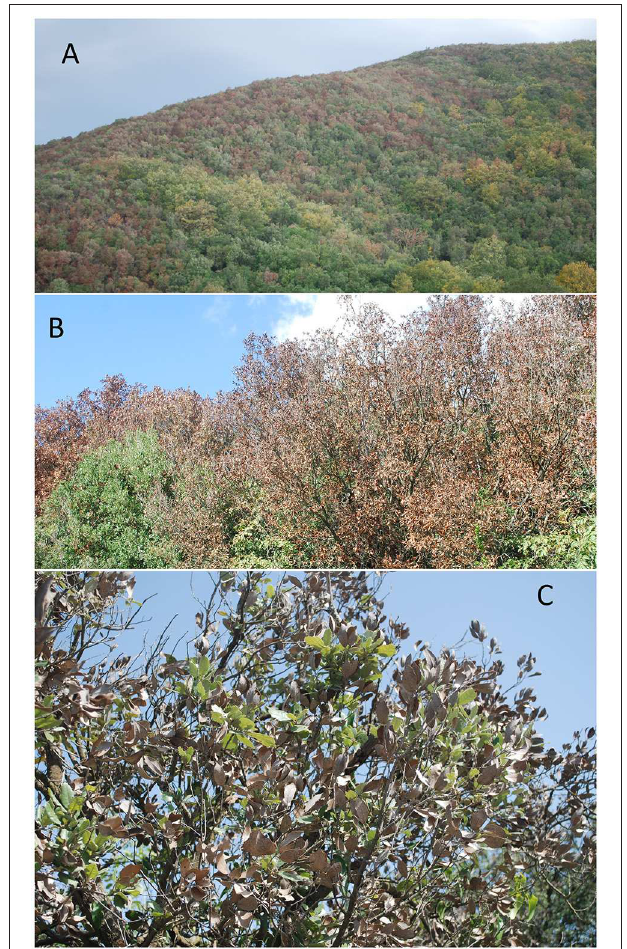
FIGURE 2 | Images of drought impact and recovery on Mediterranean vegetation in Tuscany (Italy) after the drought and heat event of summer 2017. (A) Impact at landscape level (November 2017). (B) Crown dieback on Quercus ilex (November 2017); (C) Partial crown recovery on Quercus ilex (July